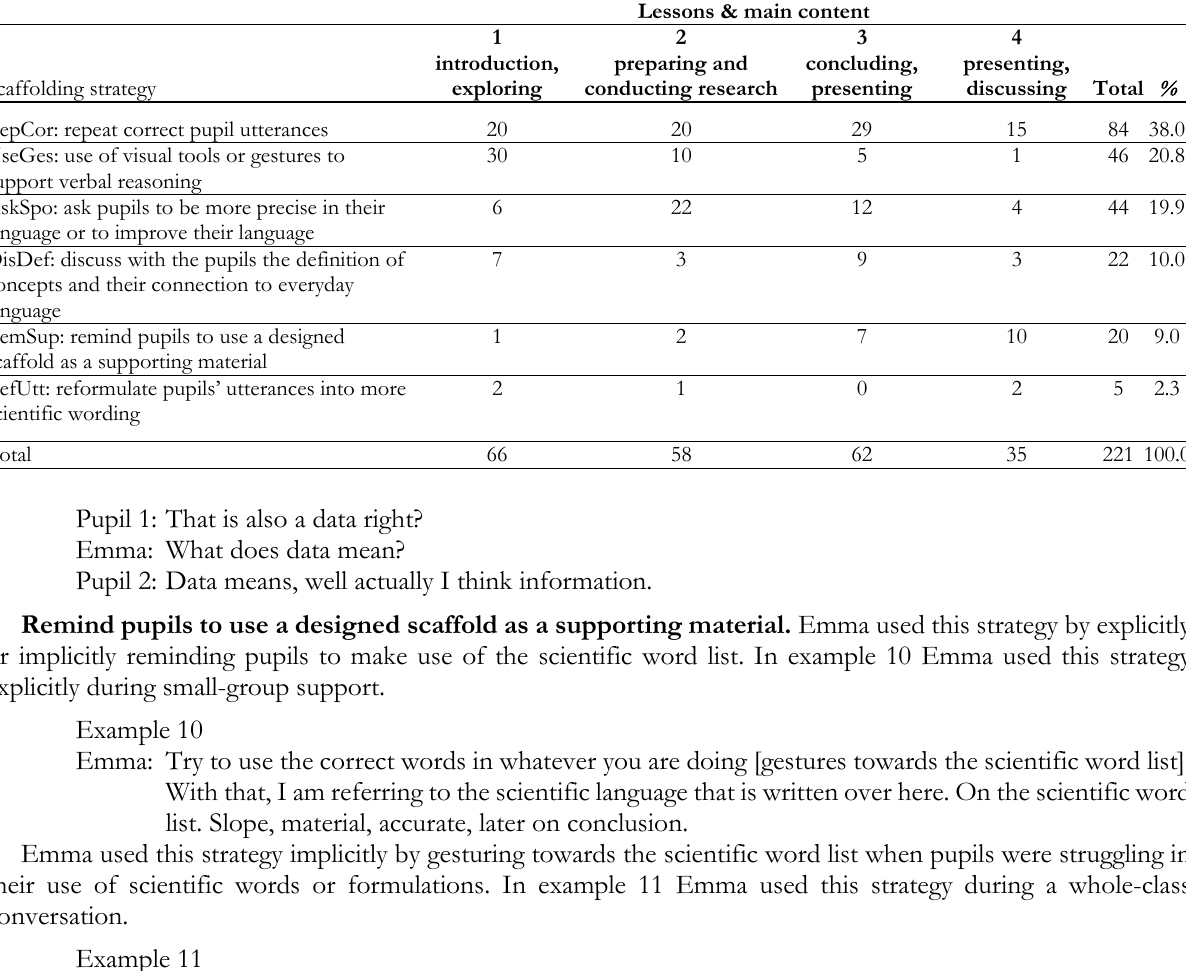
Table 4. Frequencies and percentages of used scaffolding strategies during the